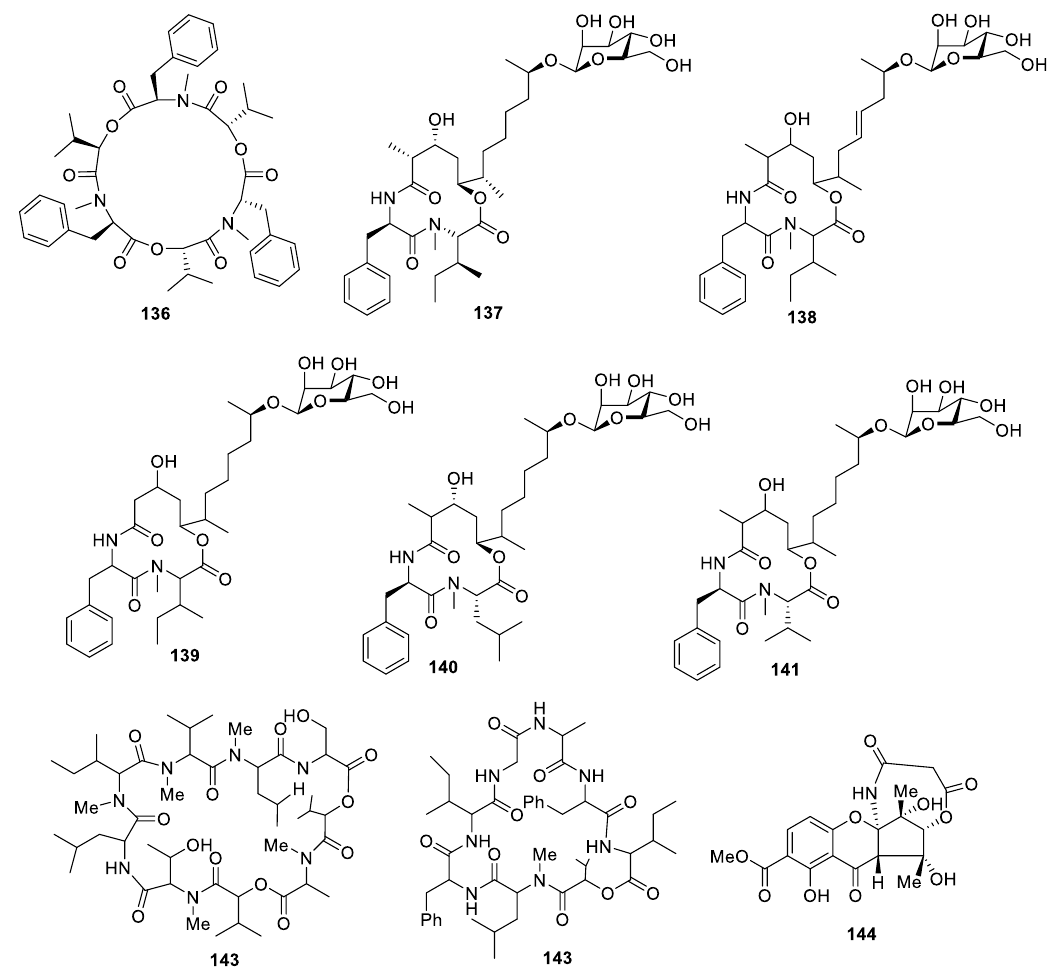
Figure 5. Chemical structures of peptides ( 136 – 144 ).